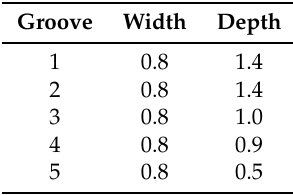
Figure 2. Scheme of grooves in piston with the position R12. First and second grooves are facing outlet. Table 1. Dimensions of grooves in piston. All the dimensions are in